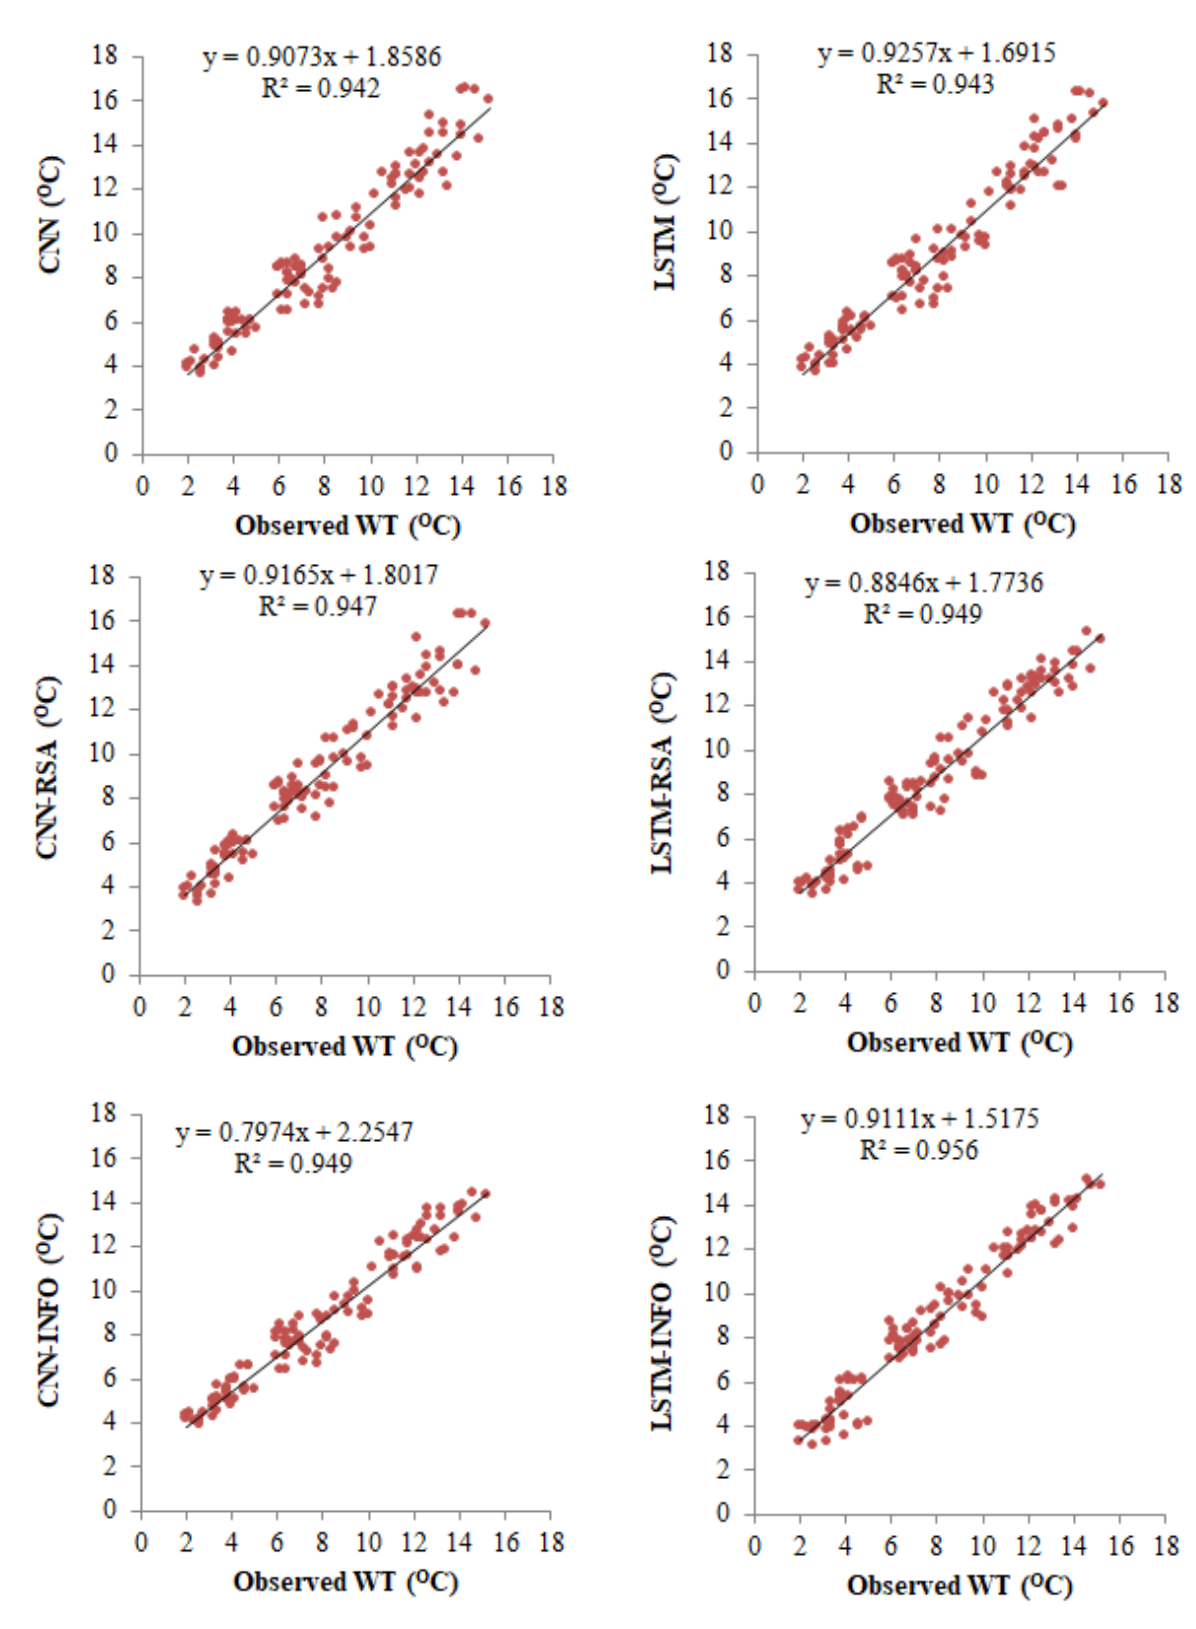
Figure 7. Scatterplots of the observed and predicted water temperature using different CNN- and LSTM-based models in the test period with the best input combination.